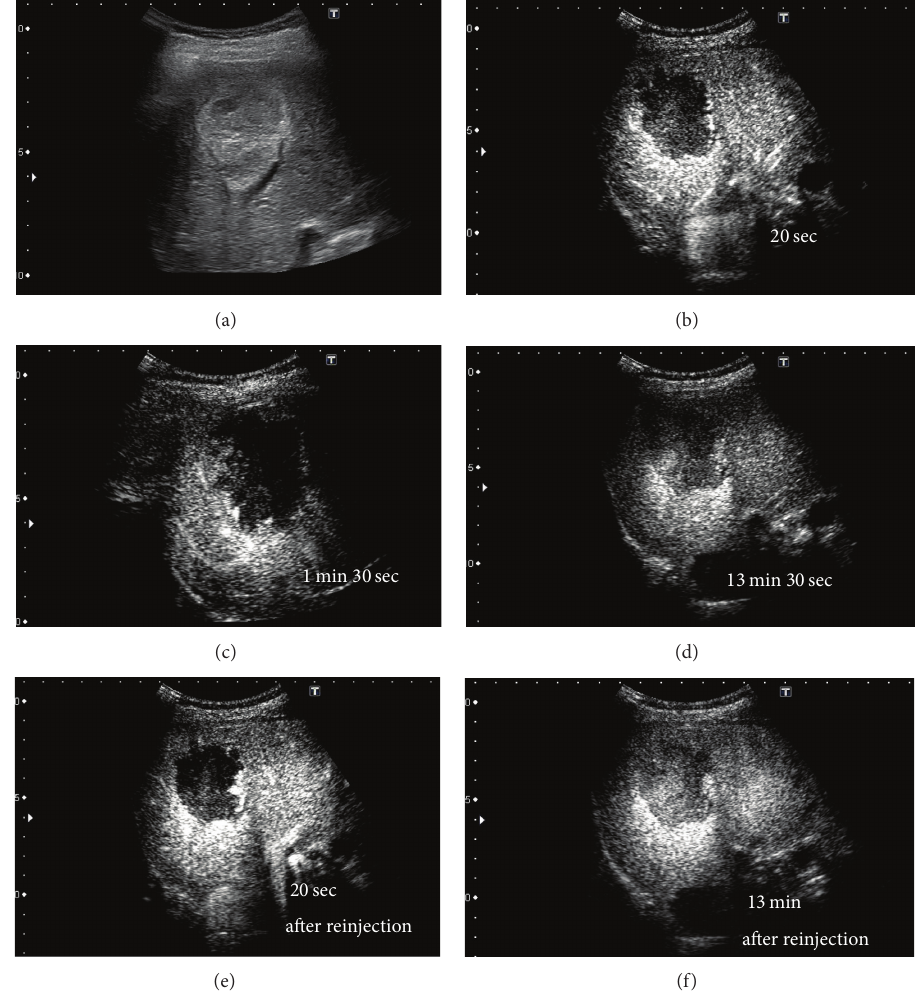
Figure 4: Intranodular dynamic image of the hepatic hemangioma in tumor 2. (a) B-mode US shows a nonhomogeneously hyperechoic lesion approximately 6cm in size in the right lobe of the liver. (b) Sonazoid contrast-enhanced US in the early vascular phase reveals typical “peripheral globular enhancement” of the lesion. (c) The lesion shows progressive “partial centripetal filling-in” during the late vascular phase. (d) The tumor is visualized as a hypoperfusion image in the Kupffer phase. (e) The same pattern is apparent 20 s after reinjection of Sonazoid: typical “peripheral globular enhancement” of the lesion in the early vascular phase 20s after the first injection of Sonazoid. (f) Parenchymal perfusion 13min after reinjection results in a hypoperfusion image similar to that in the Kupffer phase after the first injection of